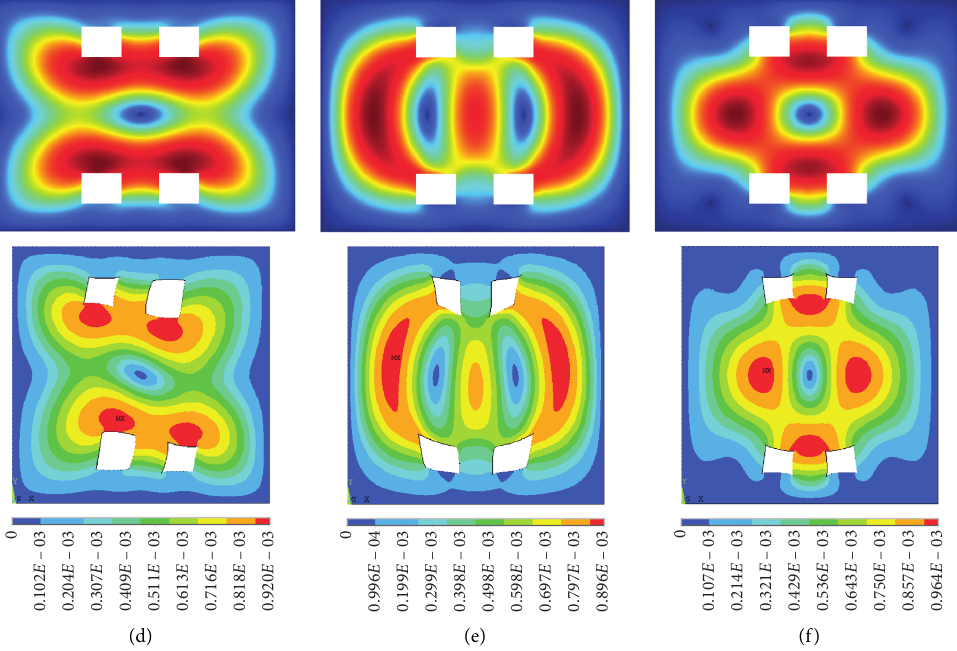
Figure 3: The first six mode shapes for the square plate with four cutouts. (a) The first mode; (b) the second mode; (c) the third mode; (d) the fourth mode; (e) the fifth mode; (f) the sixth mode. Upper: the present results; lower: the ANSYS